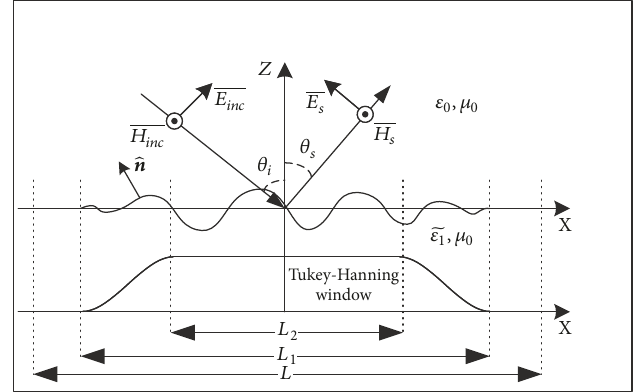
Figure 2: Comparison of linear and nonlinear wave height and slope distribution.